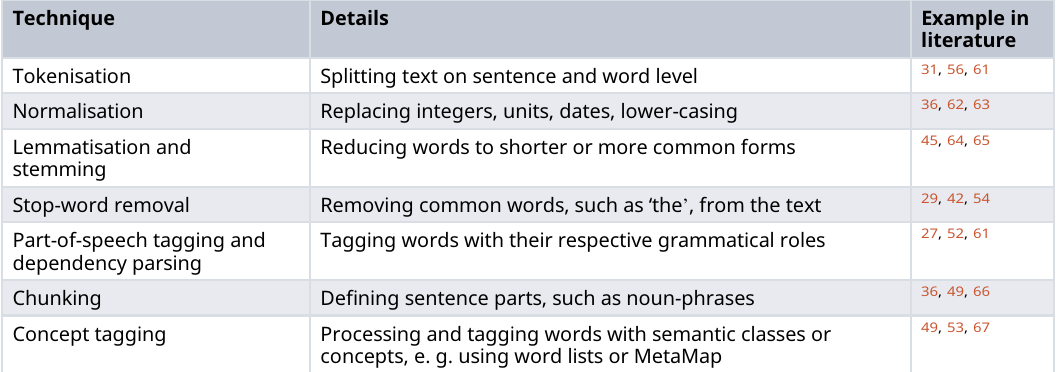
Table 1. Pre-processing techniques, a short description and examples from the